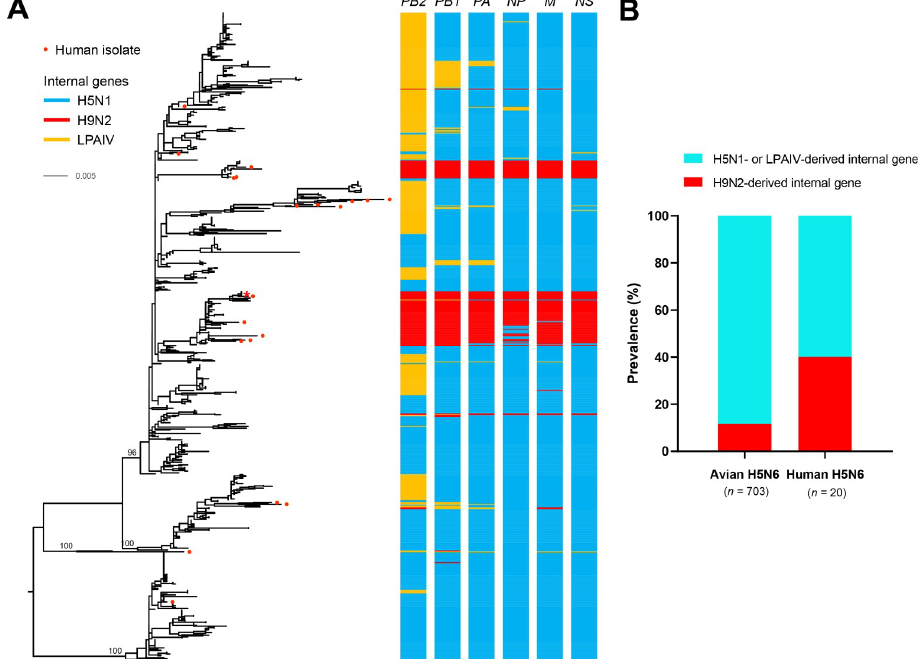
Fig 1. Phylogenetic analysis of H5N6 viruses. (A) Phylogenetic analysis of H5N6 viruses in China. The clade origins of each internal gene are indicated by different colored bars. Detailed phylogenetic trees are available as S1 Fig and S1 Table. H5N6 human strains are marked as red circles, virus labeled with a red asterisk was used in the present research. (B) Frequencies of H5N6 viruses carrying H9N2 virus-derived internal genes of human and avian origin.